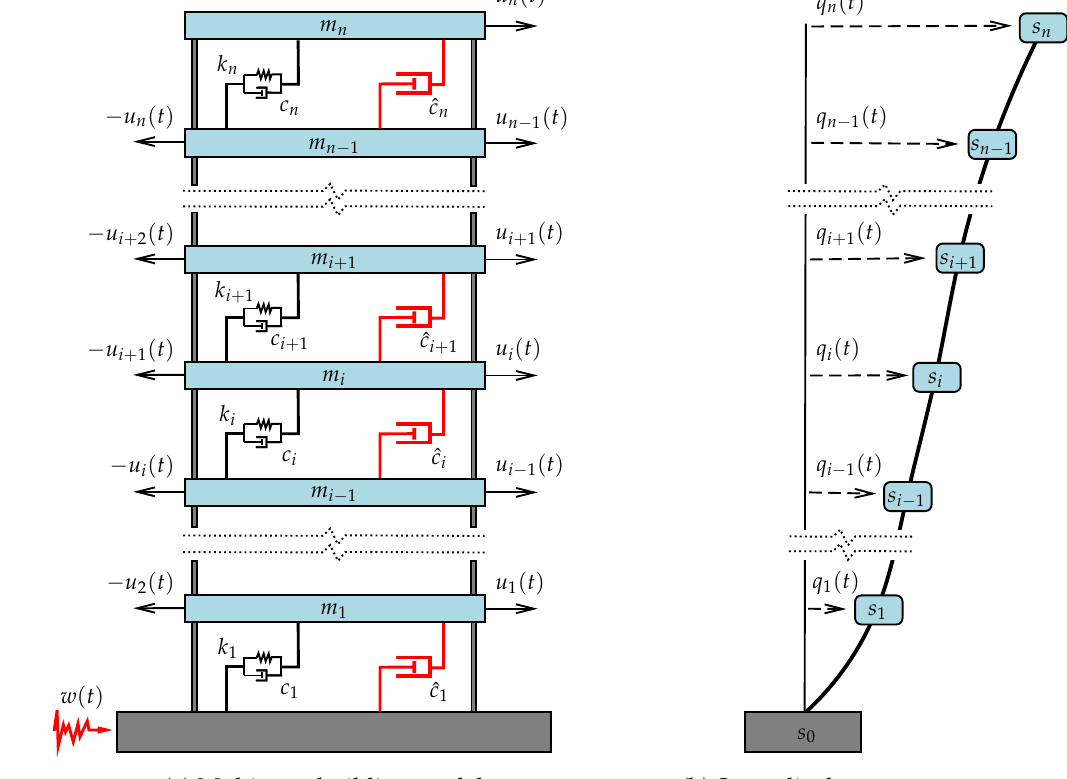
Figure 2. Schematic model of a multistory building equipped with a complete set of interstory fluid viscous